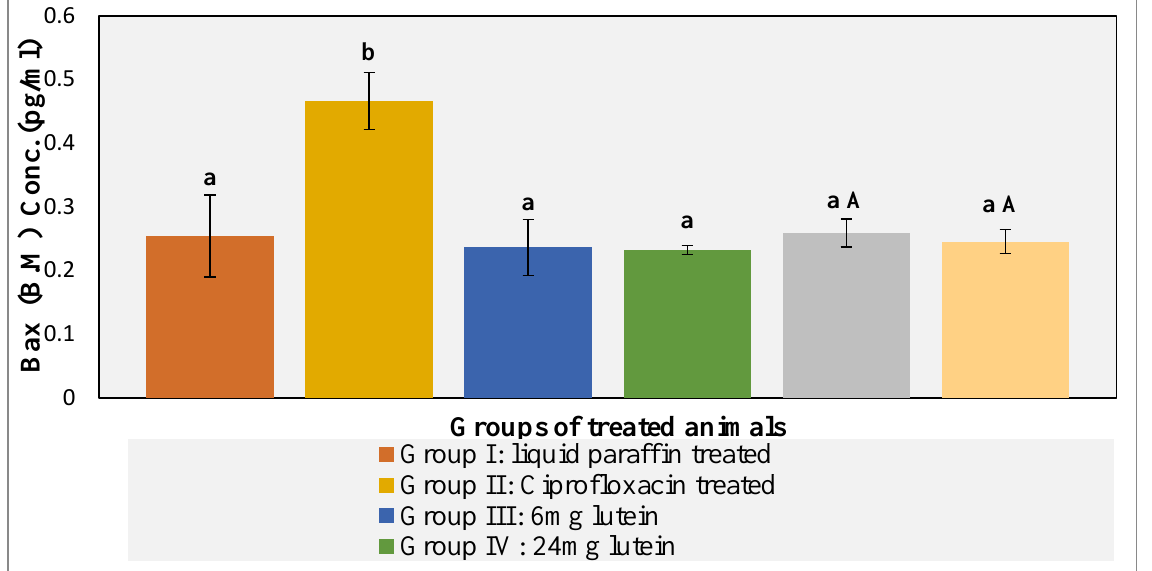
Figure 3. Effects of various treatments on Bax levels in BM tissues homogenates of rats. Data are expressed as Mean ± SD, n =6. Values with non-identical small letters (a, and b) are significantly different ( P < 0.05). Values with an identical capital letter (A) are non-significantly different ( P >